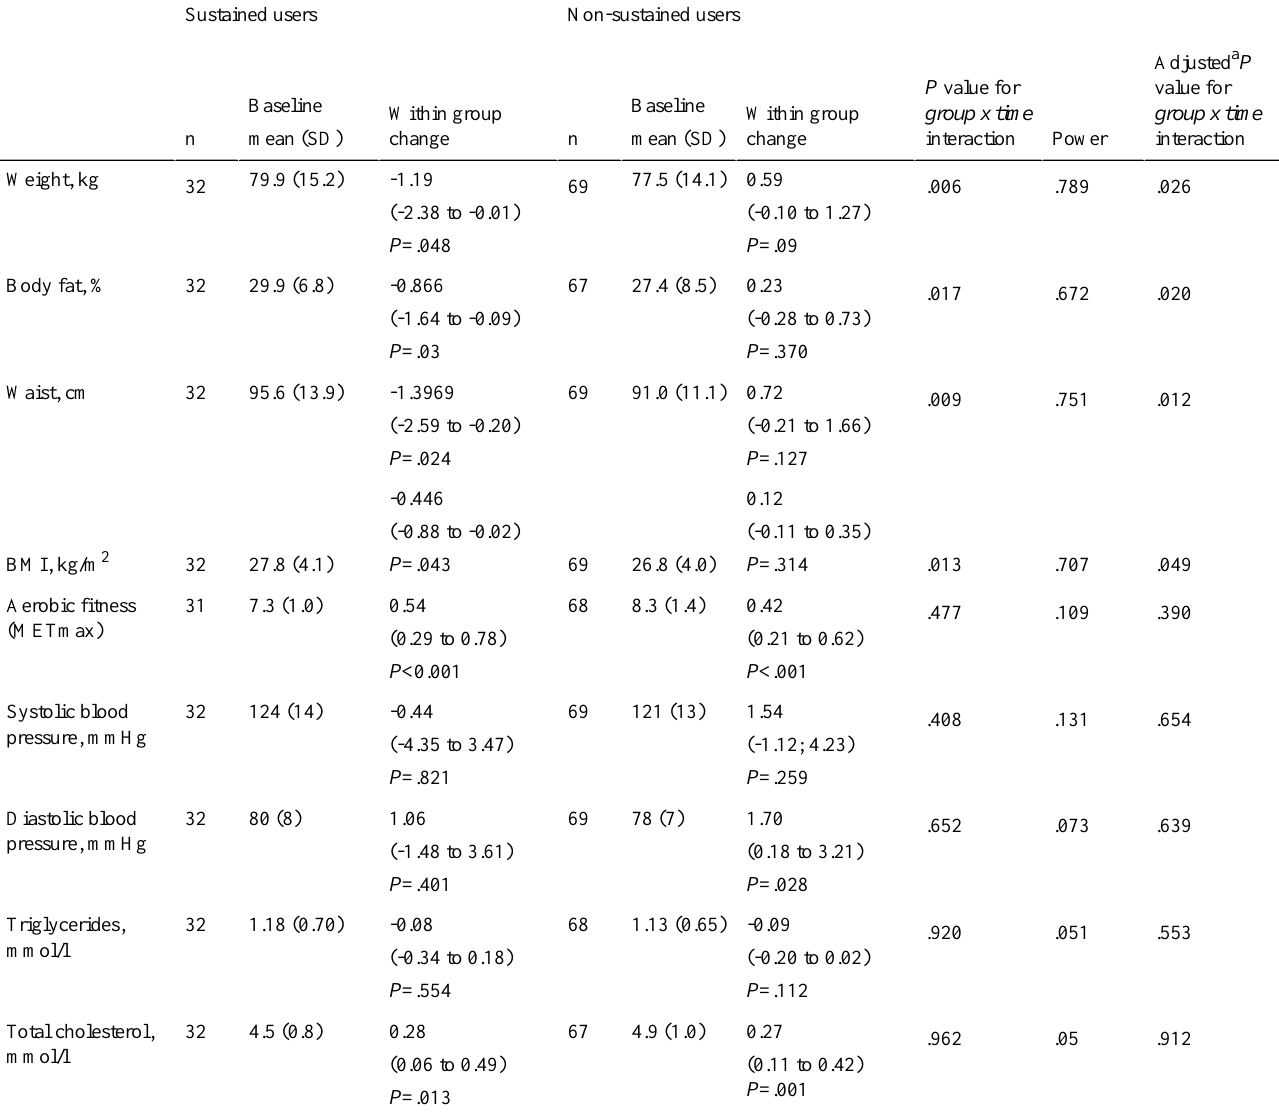
Table 5. Changes in anthropometric and physiological variables as mean change within groups and their 95% confidence interval. n denotes the number of subjects for whom the measurements were available and P values for group x time interaction indicate the significance whether the groups have evolved differently from baseline to